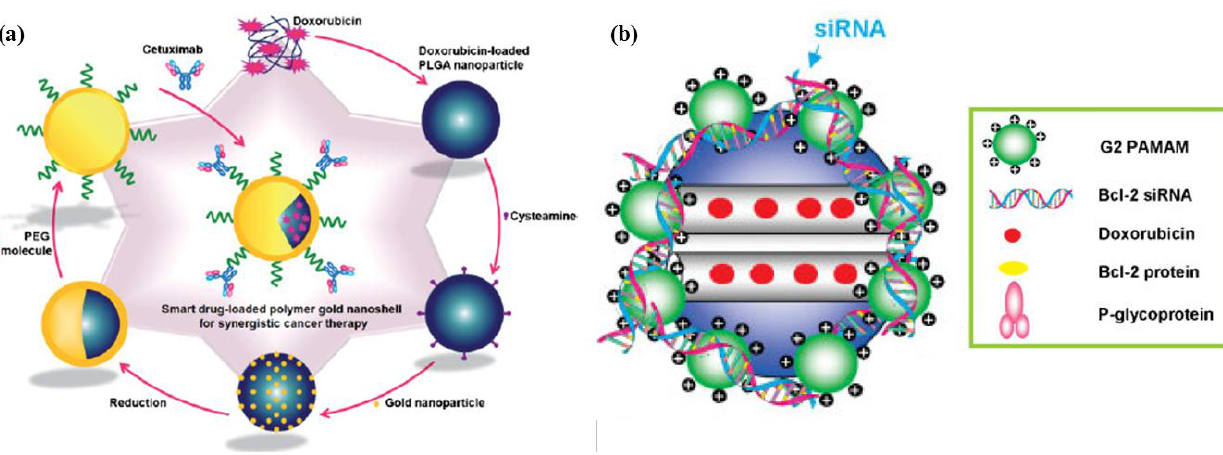
Figure 5. ( a ) Schematic illustration of multifunctional drug-loaded gold nanoshells for synergistic cancer therapy; ( b ) schematic diagram of a co-delivery system based on mesoporous silica nanoparticles (MSNs) to deliver DOX and Bcl-2-targeted